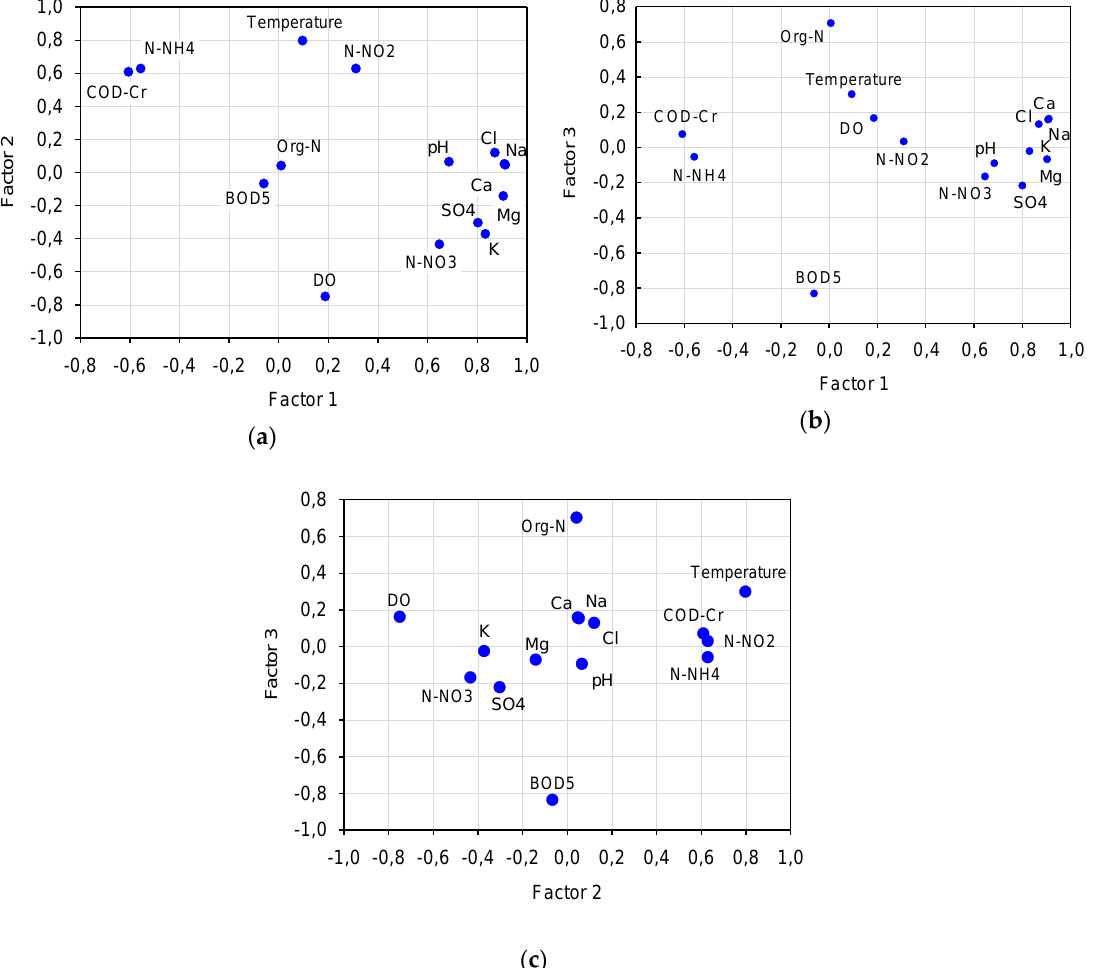
Figure 4. Factor load charts between: ( a ) factor 1 and 2, ( b ) factor 1 and 3, ( c ) factor 2 and 3. All these parameters represent aerobic conditions or are associated with the conversion of + − pollutants under aerobic conditions (N–NH 4 and N–NO 2 ). The opposite position of